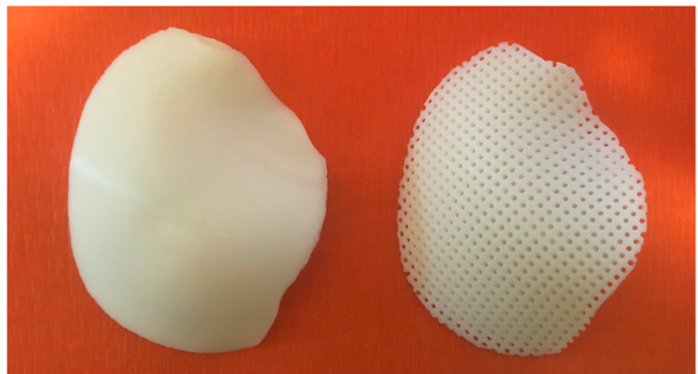
Figure 4. Three-dimensional additive manufactured devices for large cranial defect: non-porous model ( left ); model with interconnected pore network ( right ).